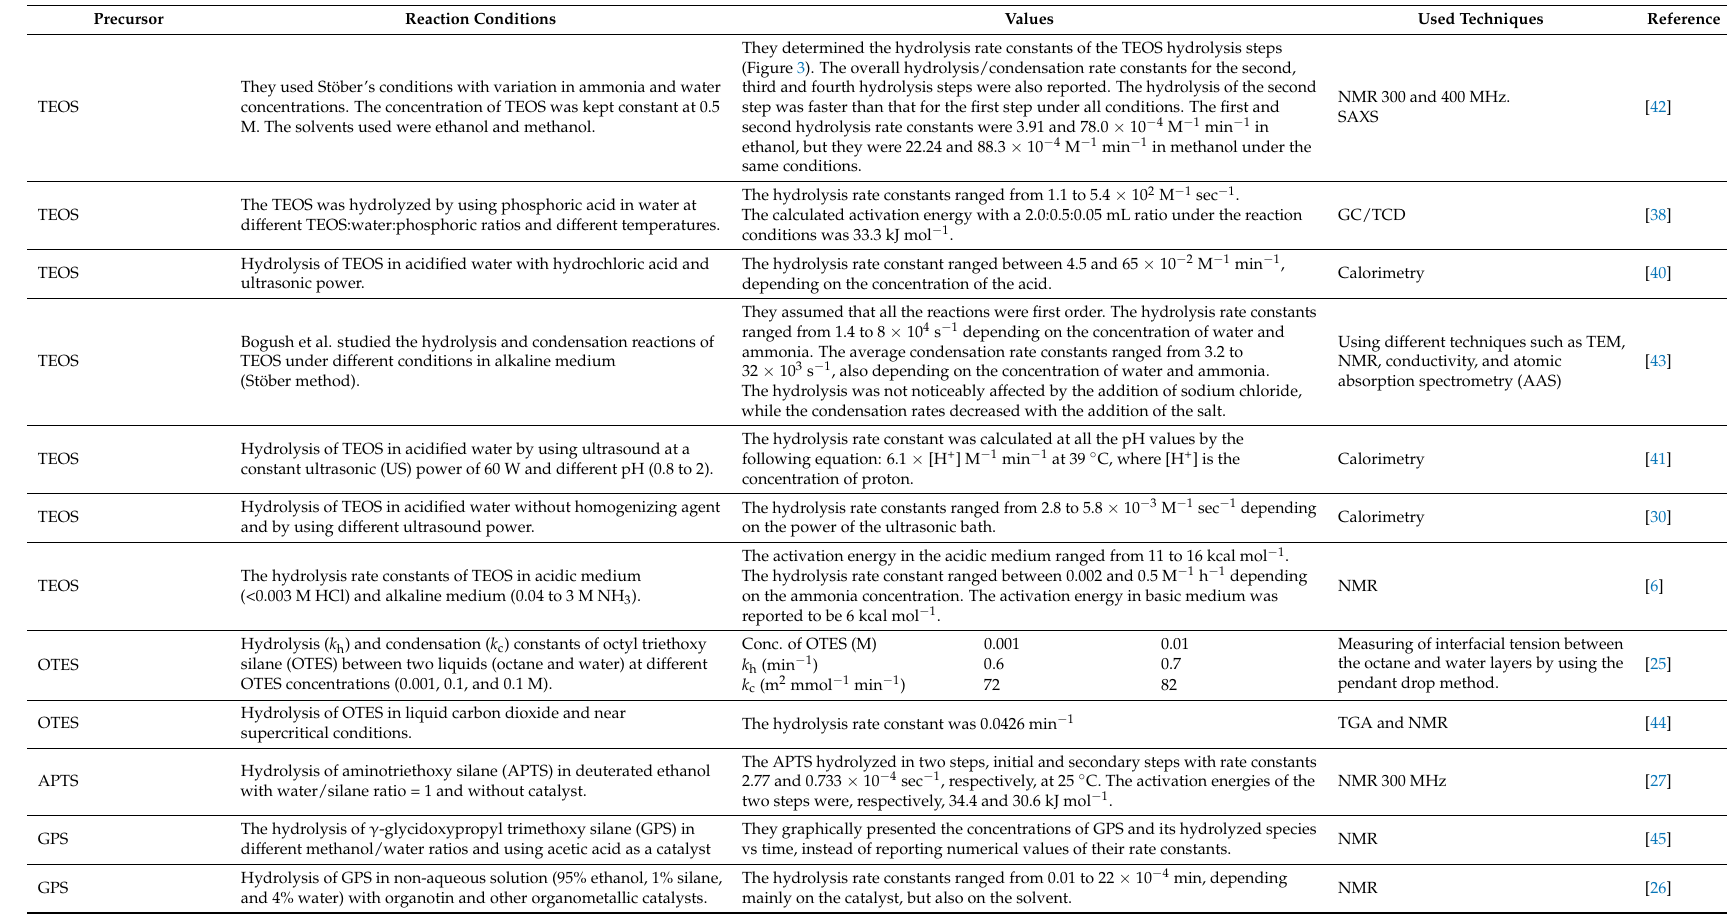
Table 1. Kinetics information for the polymerization of alkoxysilanes and organoalkoxysilanes. Precursor Reaction Conditions Values Used Techniques